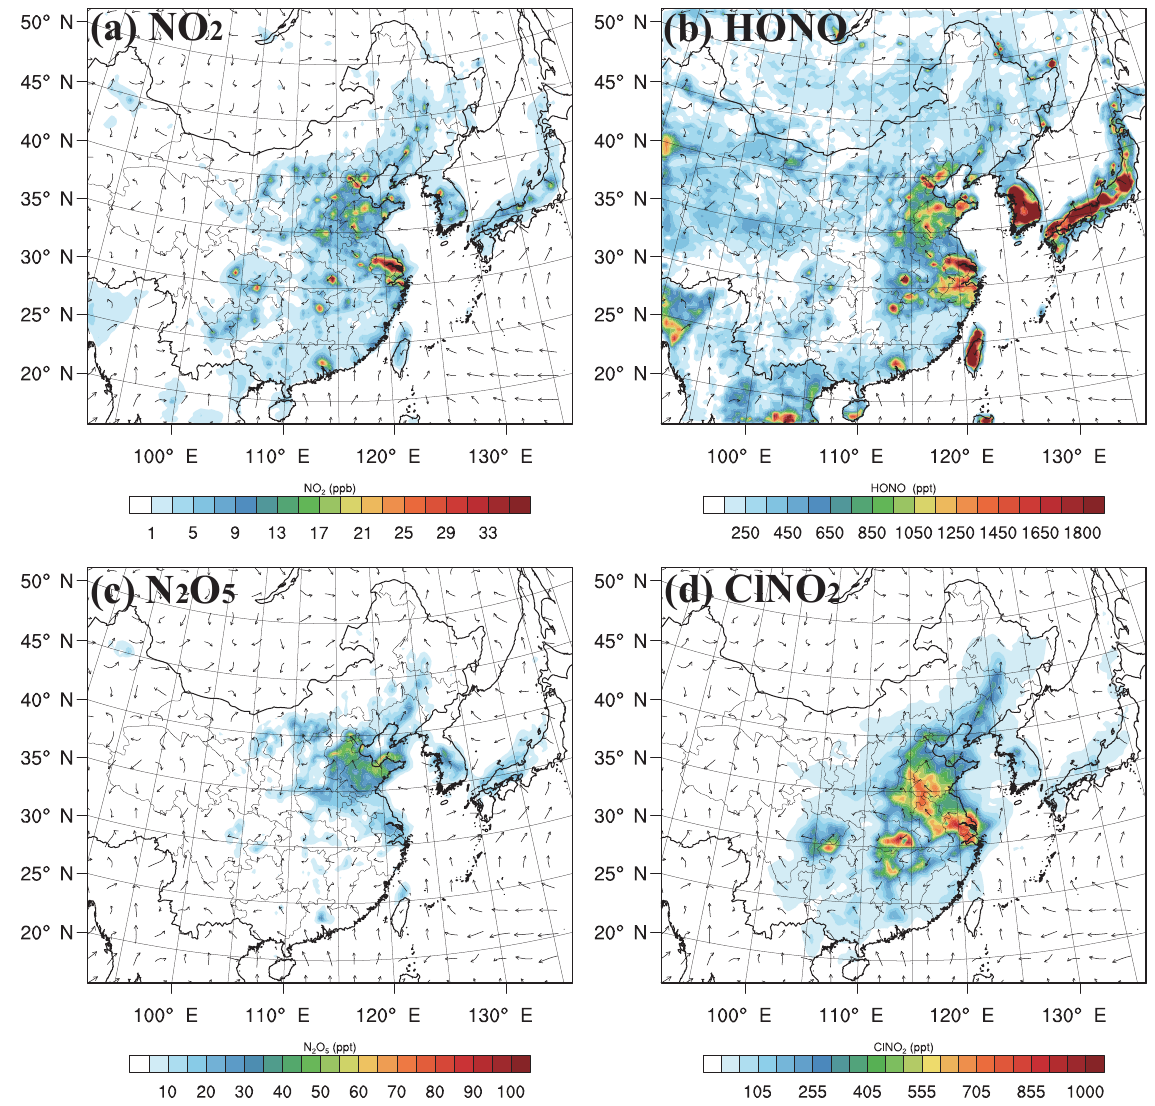
Figure 2. Spatial distributions of averaged (a) NO 2 (ppb), (b) HONO, (c) nighttime N 2 O 5 (18:00–06:00 local time, LT), and (d) nighttime ClNO 2 (ppt) in the ReNOM case at the surface ( ∼ 30m) during the simulation period (26 June–7 July